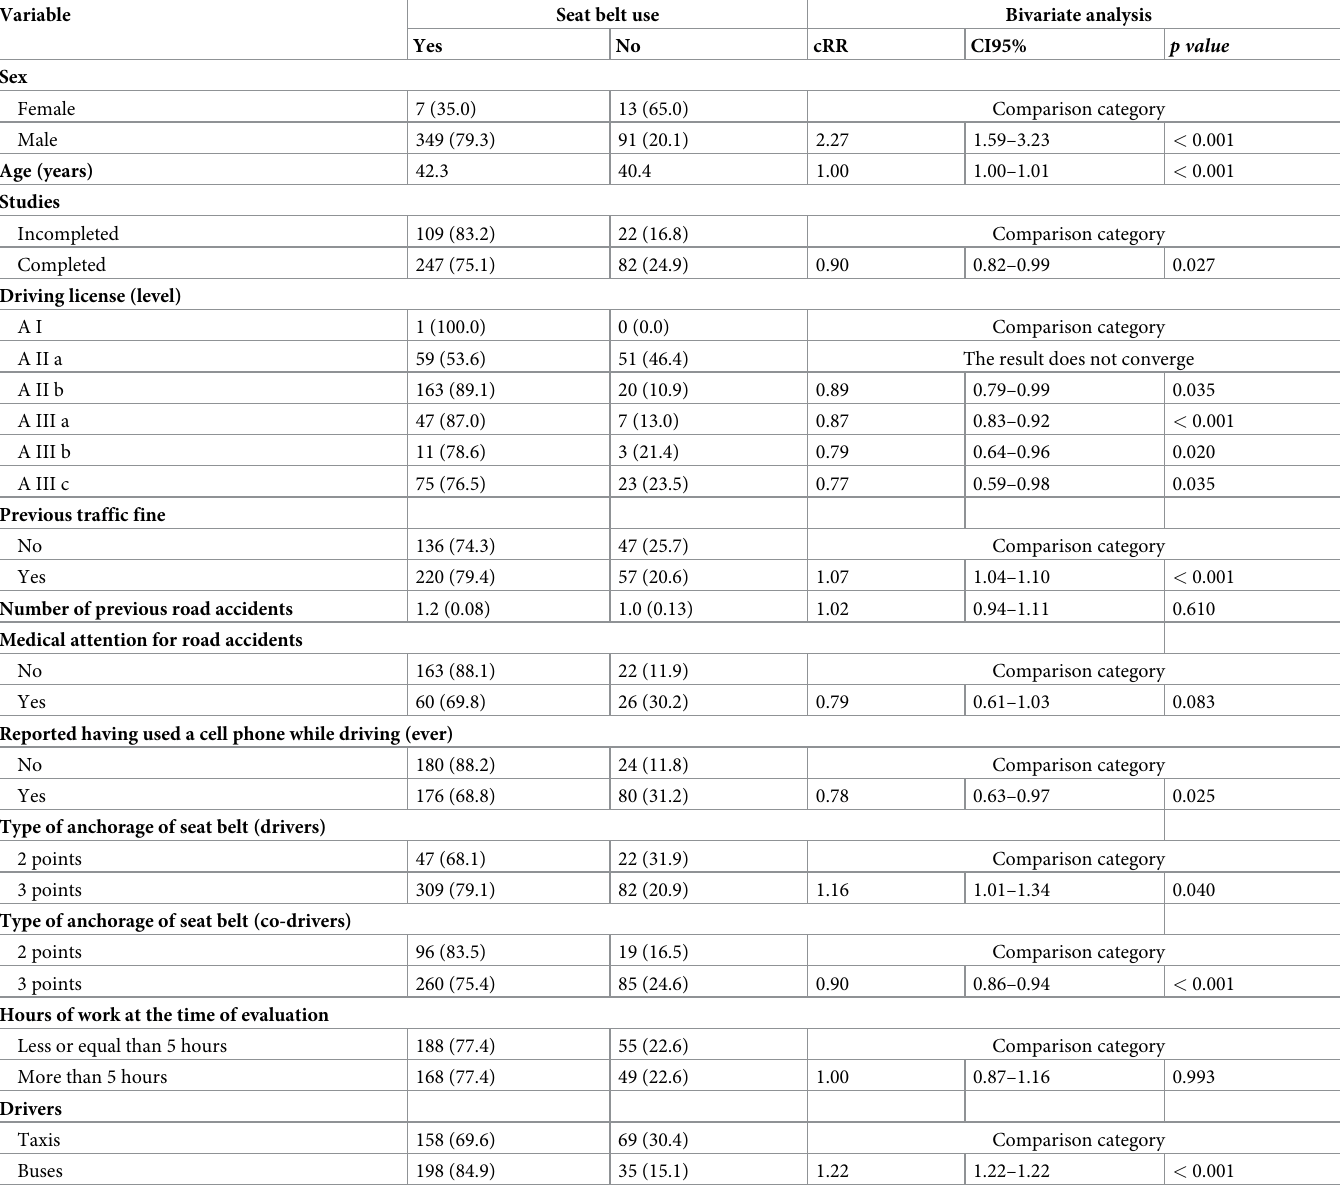
Table 3. Bivariate analysis of the risk factors associated with the use of seat belts among public transport drivers in Tacna-Peru. Variable Seat belt